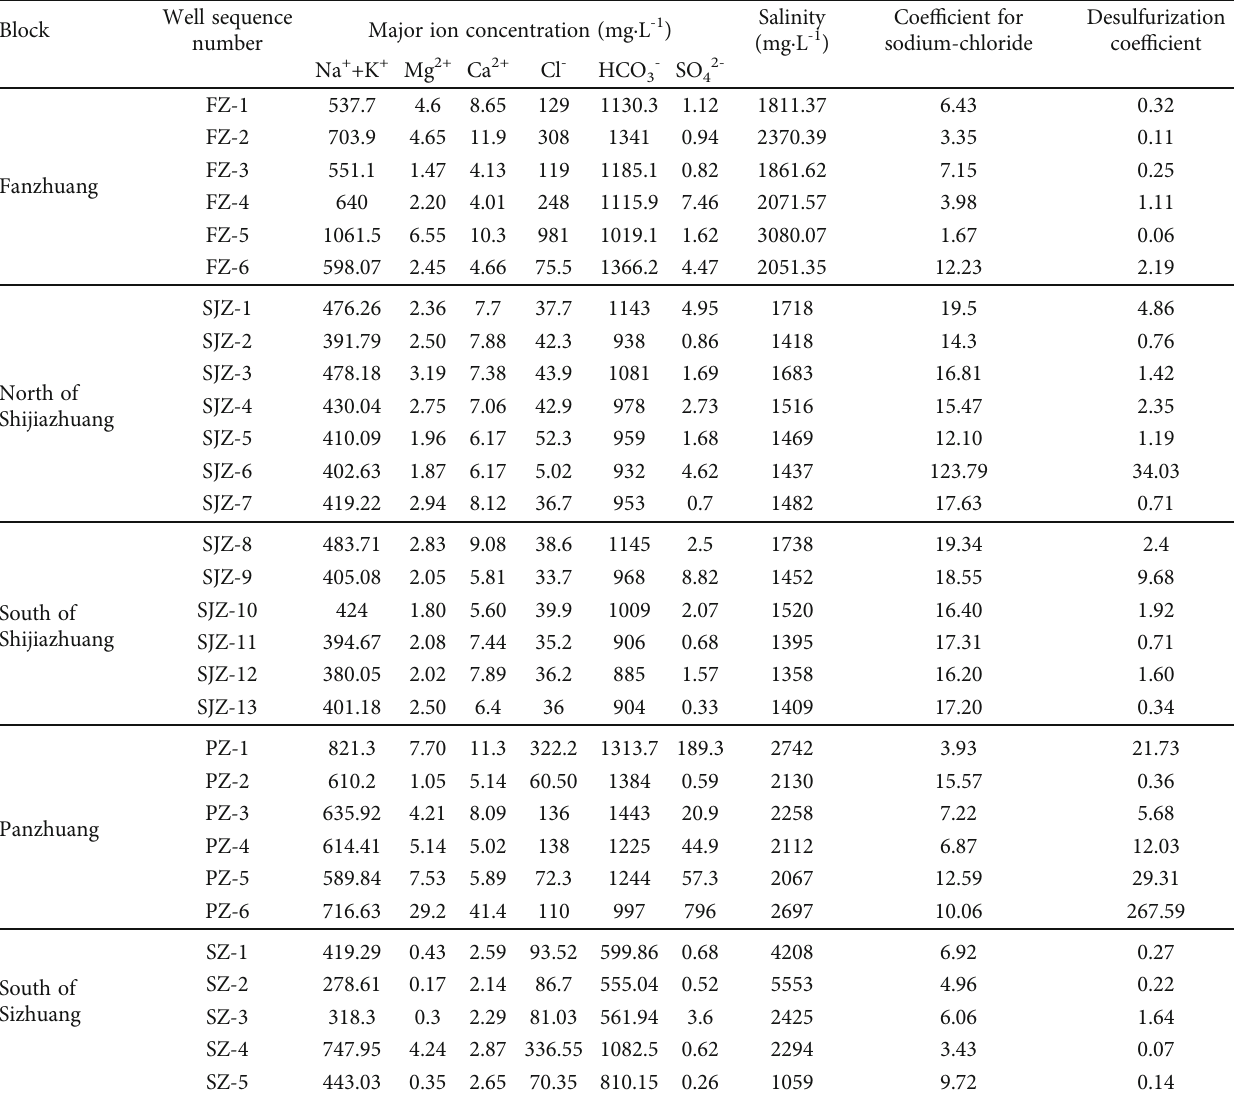
Table 2: Geochemical characteristics of water produced from CBM wells in Qinshui Basin [4, 32 – 35]. Well Block